Question: Sum up the contents of this chart in one sentence.
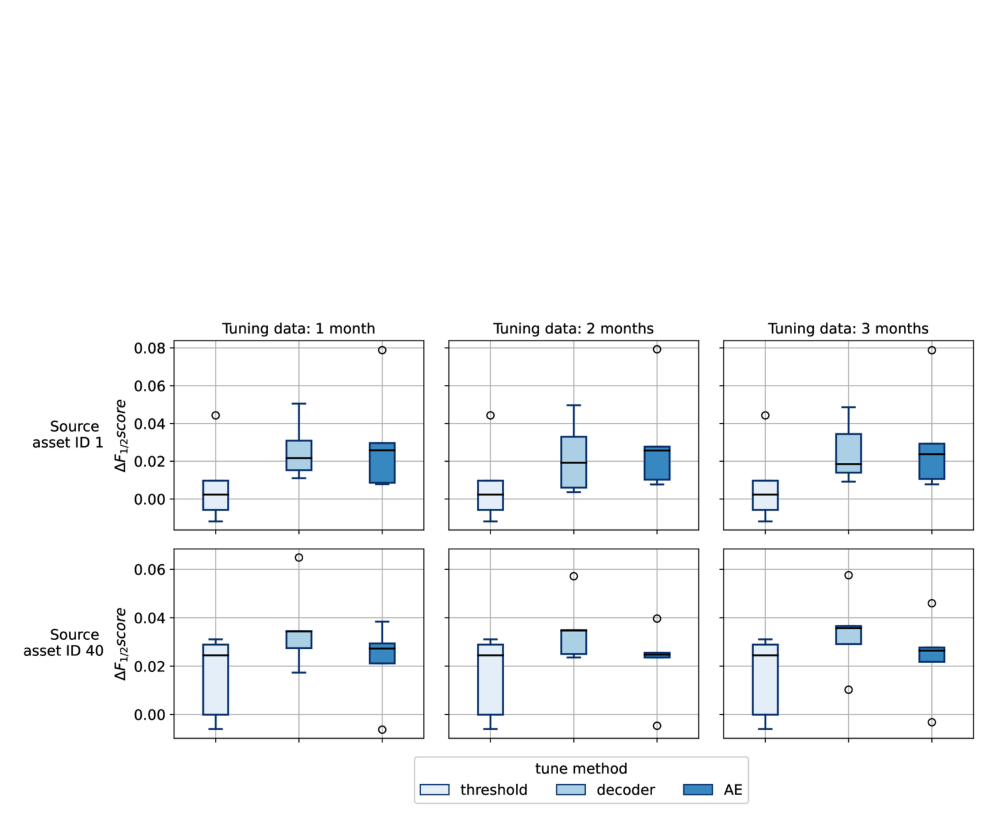
Answer: Transfer Learning results for WF B. The difference in F1/2 score with respect to the baseline model for each wind turbine is shown.